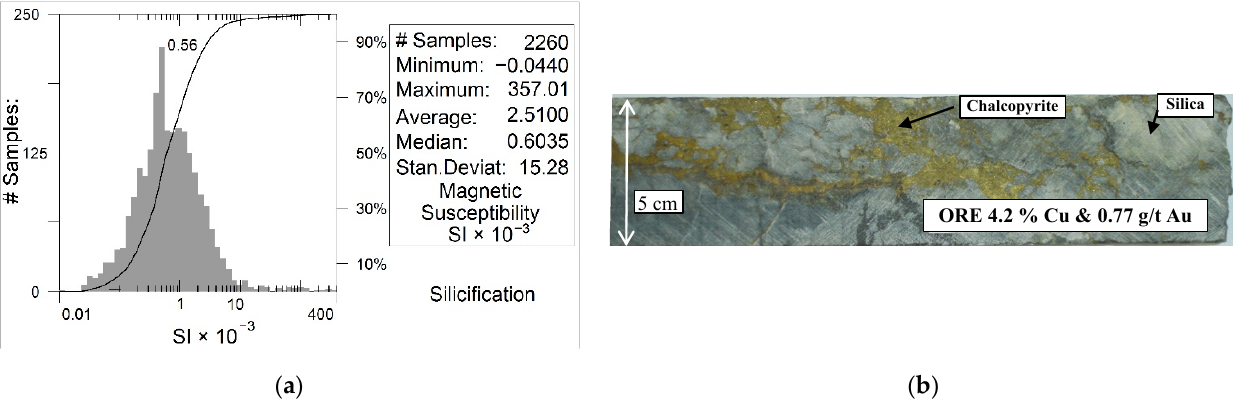
Figure 16. Silicification zone. ( a ) Statistics and histogram of the magnetic susceptibility measurements. ( b ) Core sample picture.